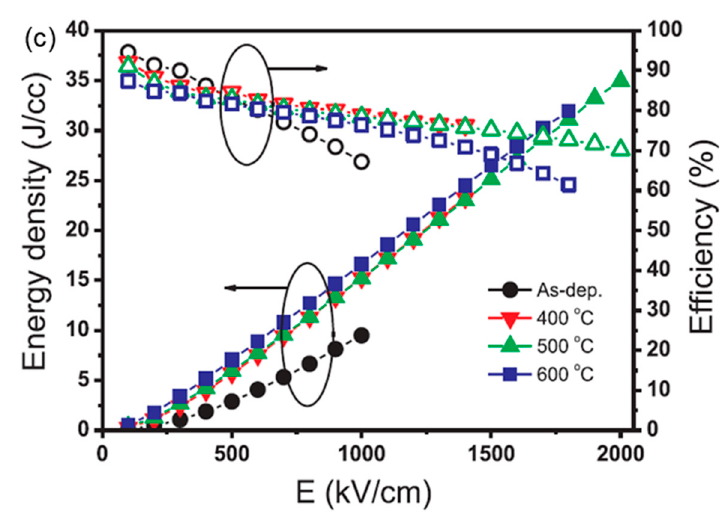
Figure 30. Schematic of comparative P – E loops of ( a ) bulk and ( b ) AD films. ( c ) Variations in energy density and efficiency of 65PMN-35PT films as a function of the electric field [76]. © Copyright 2018, Ceram. Int.